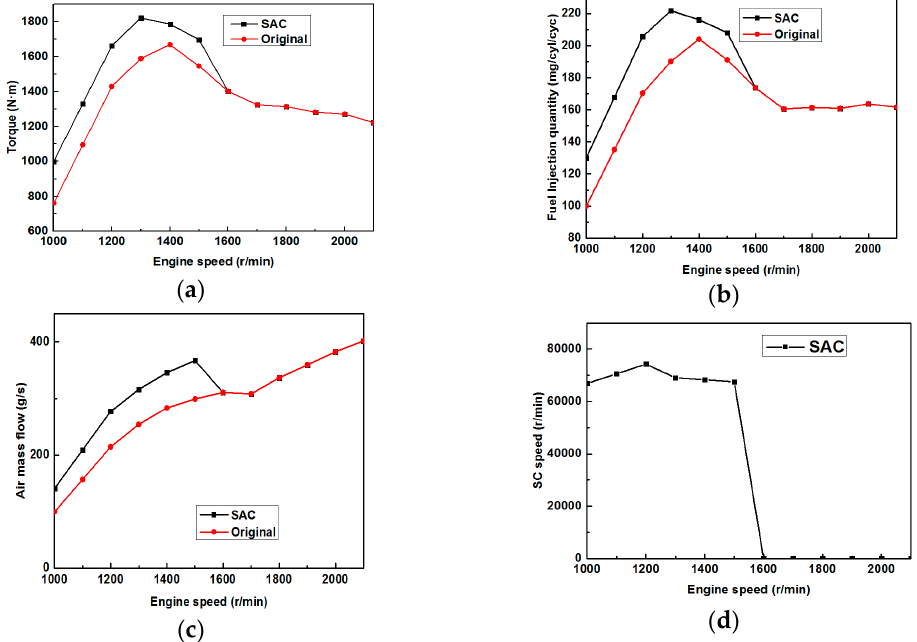
Figure 5. Full load optimization results: ( a ) Torque; ( b ) Fuel; ( c ) Air mass flow; ( d ) n sc .